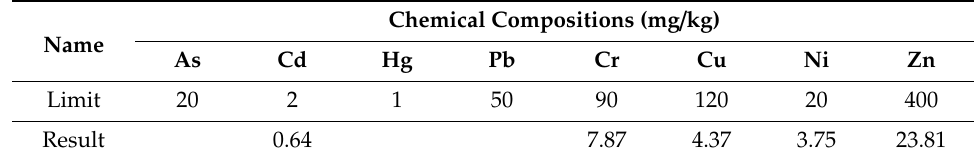
Table 3. Hazardous component test of natural zeolite.